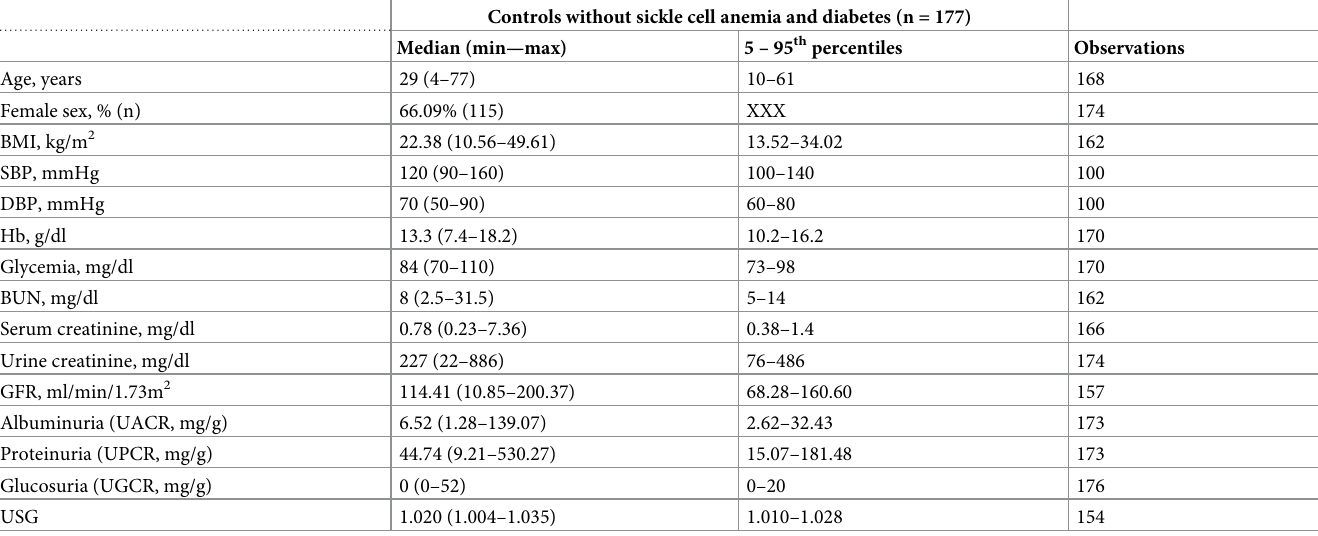
Table 1. Description of anthropometric and biochemical parameters of